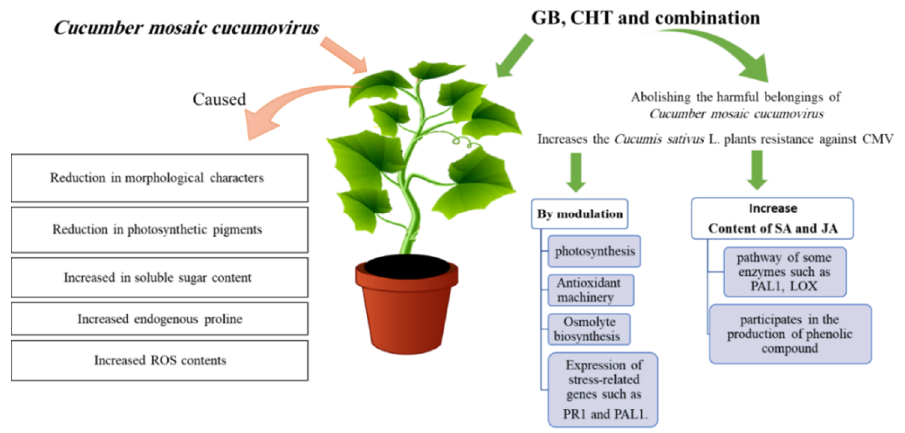
Figure 10. Model showing the role of glycine betaine (GB) and chitosan (CHT) in induce resistance in cucumber plant after CMV infection.